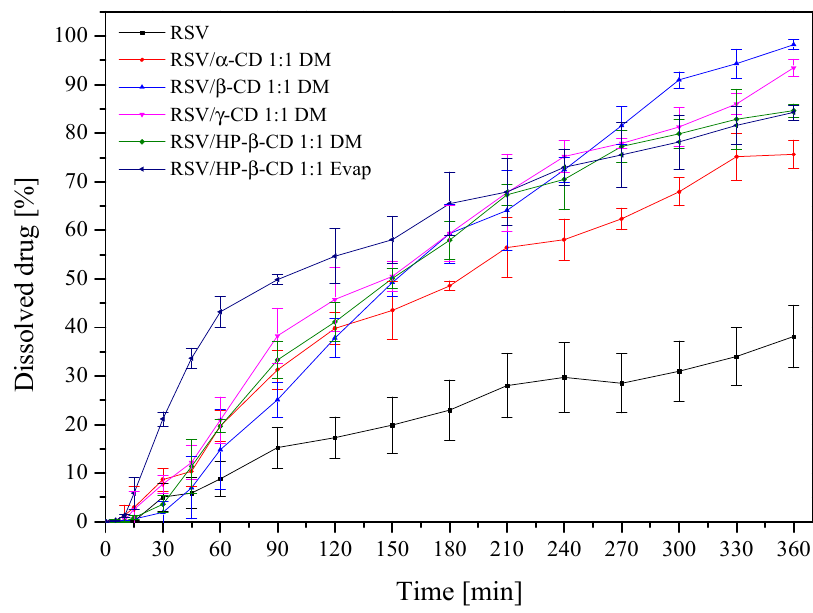
Figure 4. Powder dissolution of RSV from the powder CD systems at pH